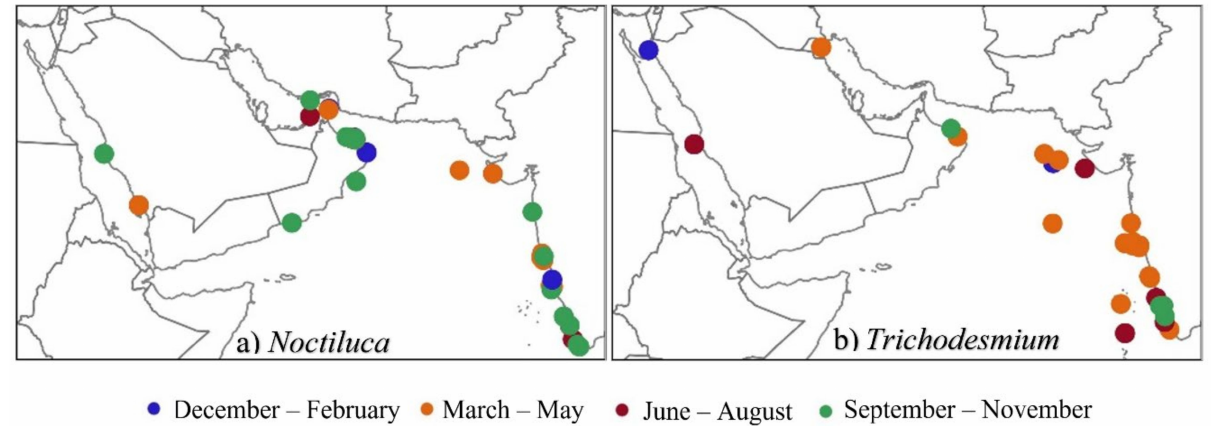
Figure 5. Seasonal spatial distribution of the two most common algal species: ( a ) Noctiluca and ( b ) Trichodesmium , causing blooms in the NIO. These are in situ data collected during the algal bloom events in the region during four different periods. The blue circles represent the appearance of species during the months of December–February, orange during March–May, red during June–August, and green during